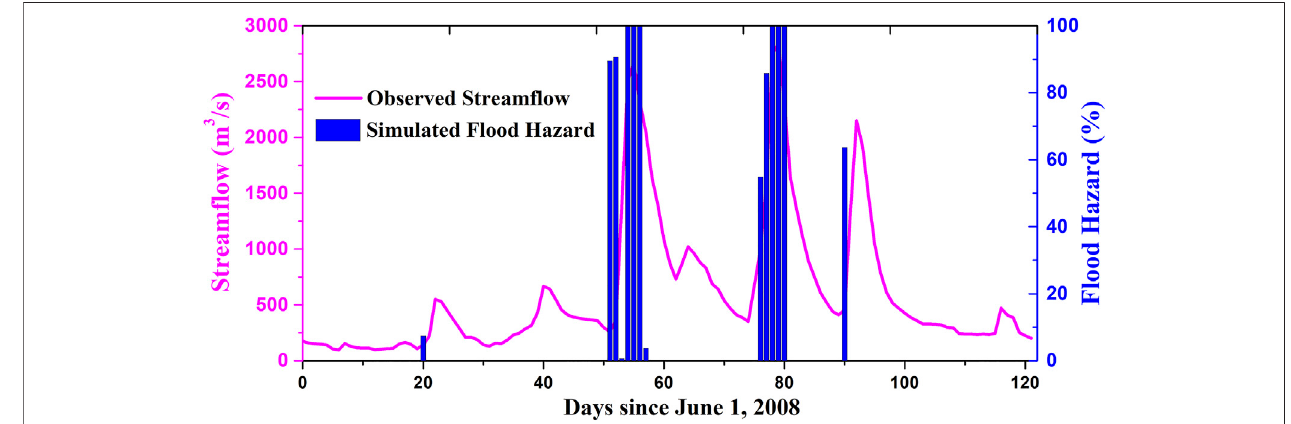
FIGURE 6 | Predicted fl ood hazard based on TFLP and TIGGE products in the WJB sub-basin during the study period.